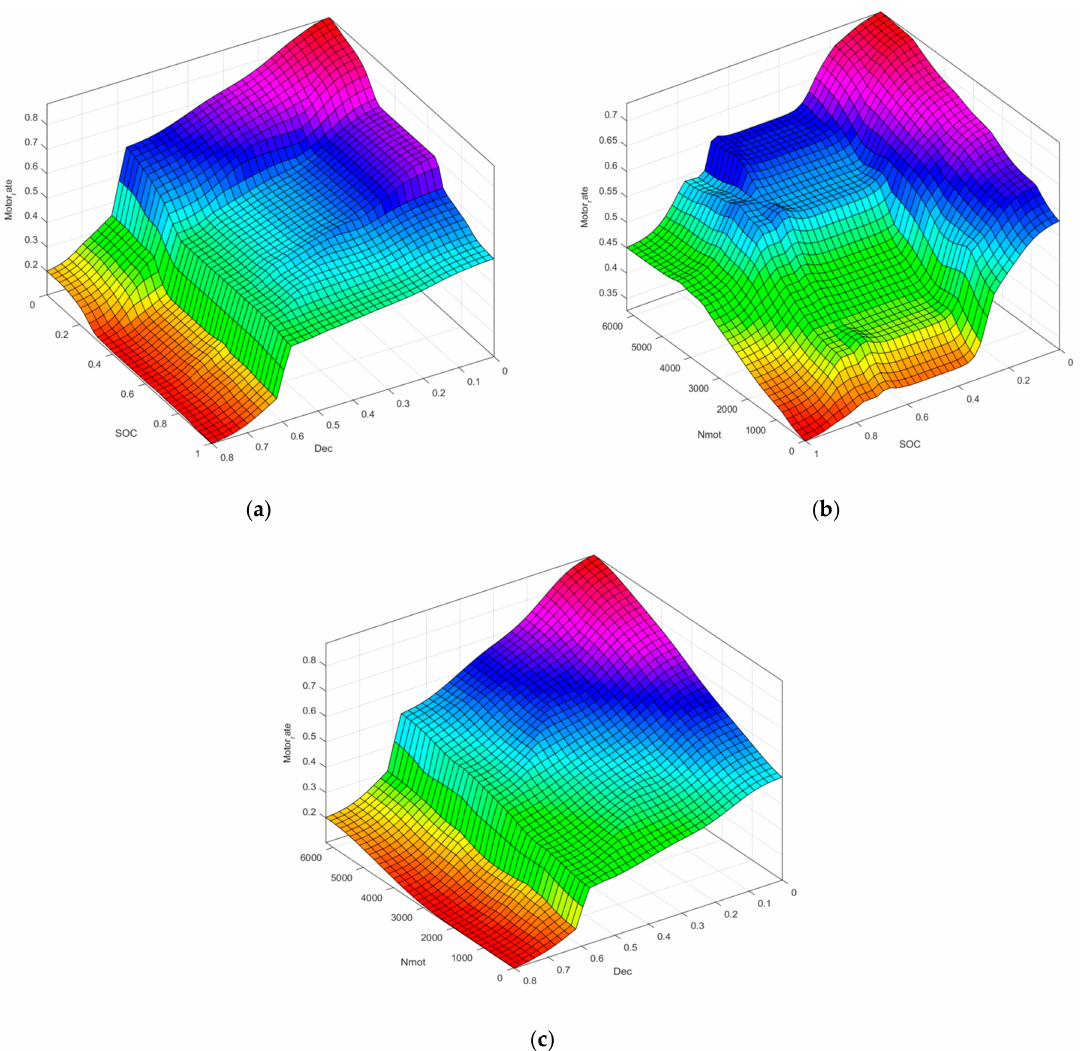
Figure 14. Braking distribution ratio ( k ) relationships among different inputs; ( a ) relationship with motor speed; ( b ) relationship with deceleration strength; ( c ) relationship with battery